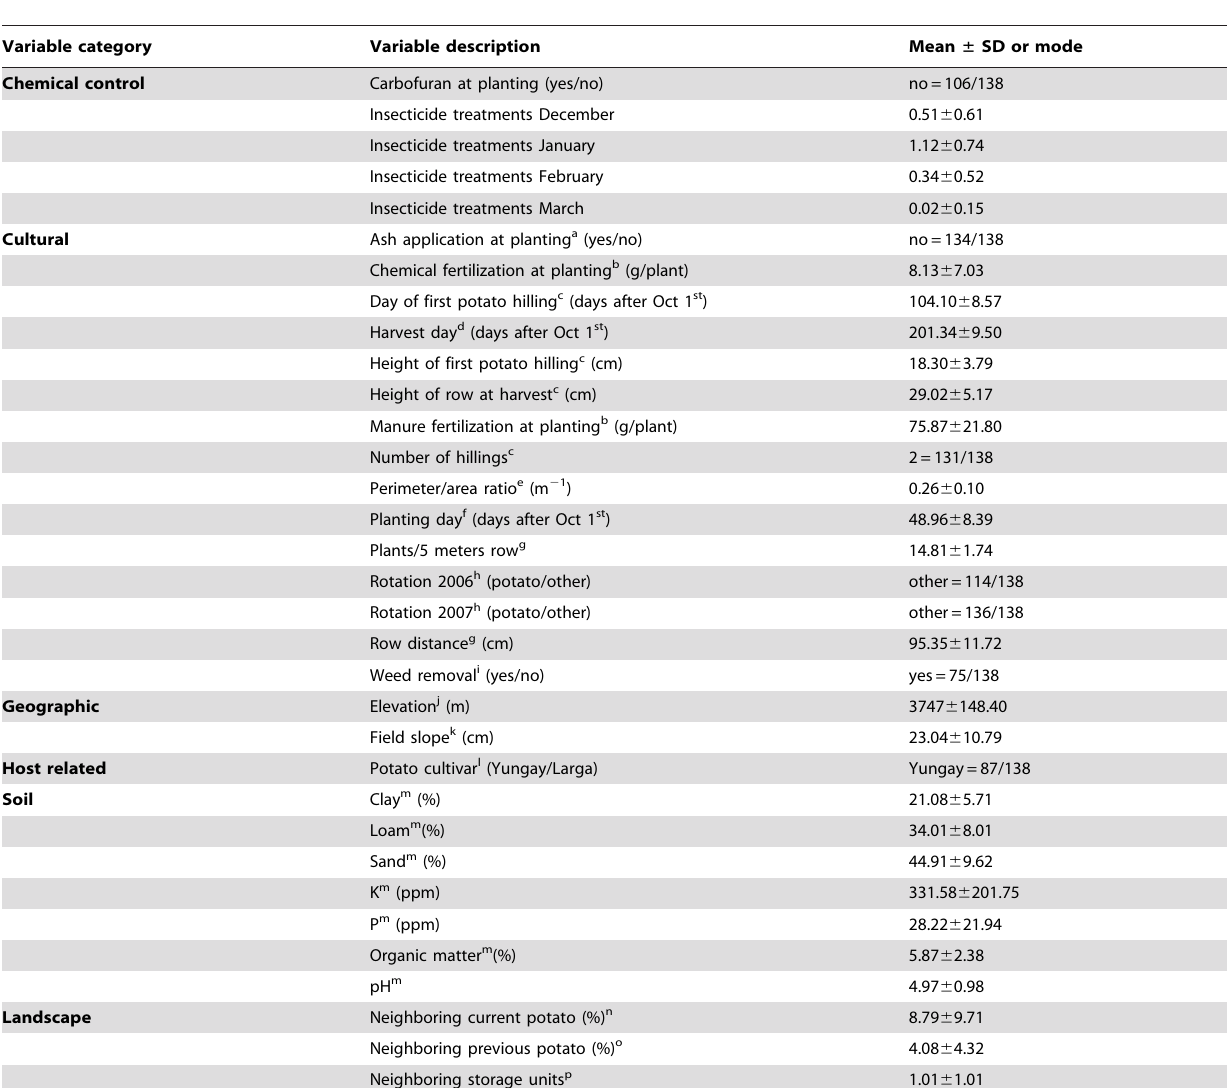
Table 1. Local and landscape features of hypothesized to exert important influences on Andean potato weevil infestations ( Premnotrypes